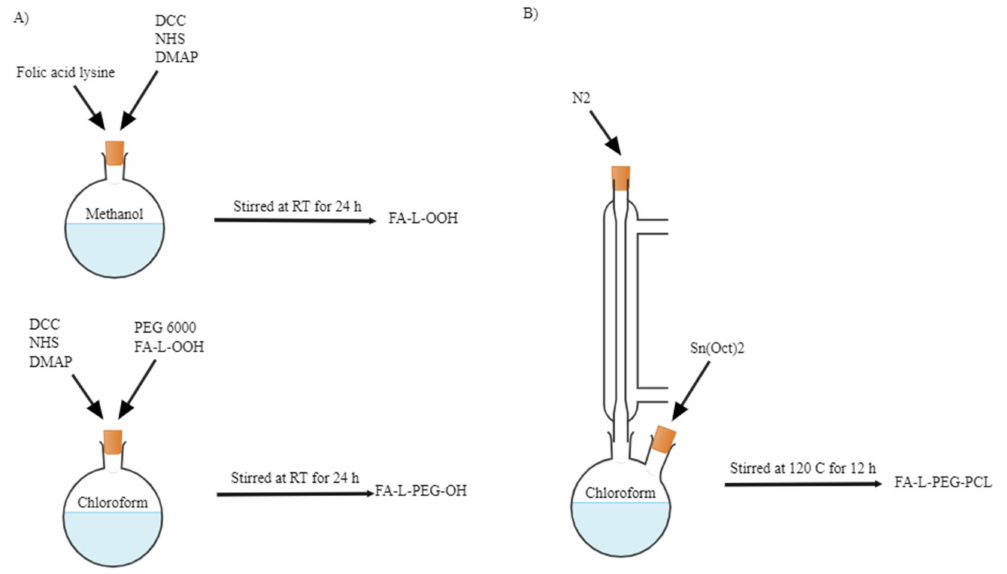
Figure 3. Preparation of ( A ) FA-L-PEG-OH and ( B ) FA-L-PEG-PCL. Reprinted/adapted with permis- sion from Elsevier